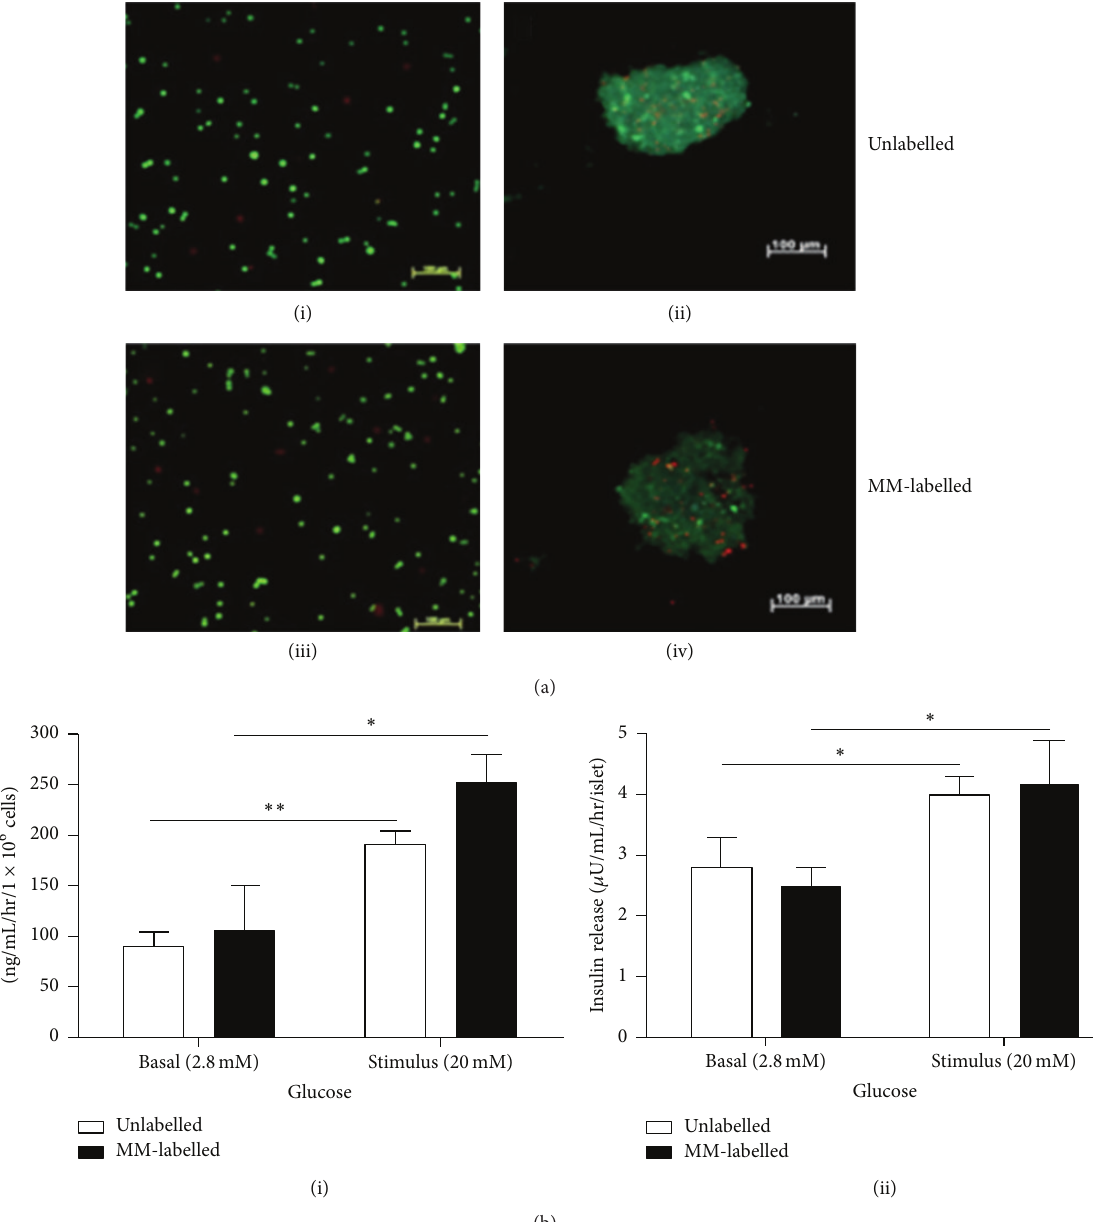
Figure 2: Viability and insulin secretion of nonencapsulated MM-labelled cells. (a) Viability images of unlabelled and MM-labelled MIN6 (i and iii) and human islets (ii and iv), respectively. Bar is 50 𝜇 m for (i) and (iii) and 100 𝜇 m for (ii) and (iv). Viability is estimated as a percentage of green (live cells) to red (dead cells) fluorescence. Values are mean ± SEM ( 𝑛 = 3 aliquots for MIN6and 𝑛 = 100 clusters for islets). (b) Glucose stimulated insulin secretion of both MIN6 (i) and human islets (ii) 24 hr after MM labelling. Values are mean ± SEM ( 𝑛 = 3 ); ∗∗ 𝑝 < 0.01 and ∗ 𝑝 < 0.05 for basal versus stimulated insulin secretion for both unlabelled and MM-labelled MIN6 and human islets, respectively (Student’s t